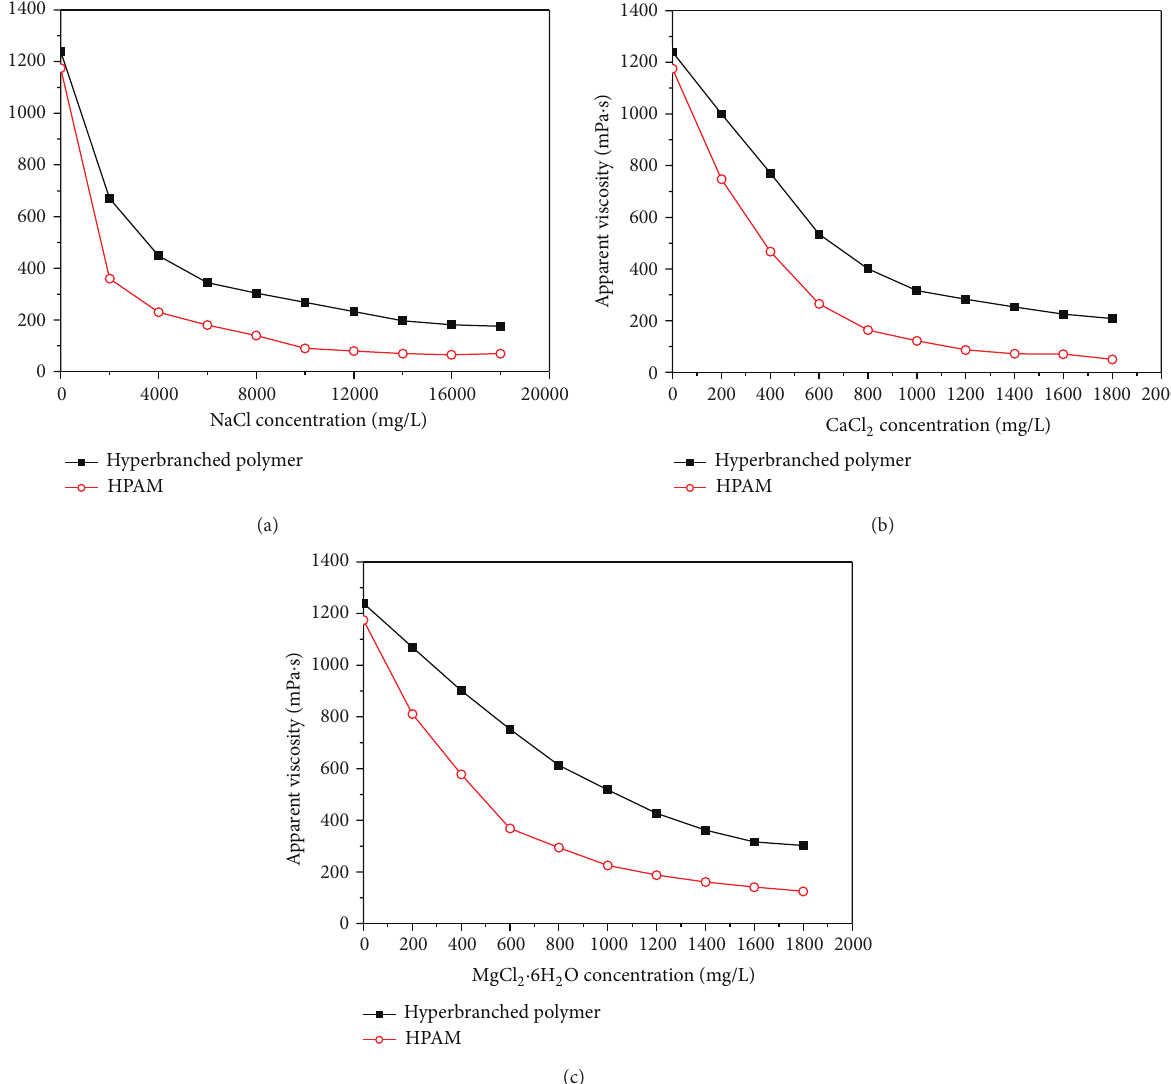
Figure 9: Salt-resistance ((a) NaCl, (b) CaCl 2 , and (c) MgCl 2 ⋅ 6H 2 O) of HPAM and hyperbranched polymer solutions (5000 mg/L) at 20 ∘ C.